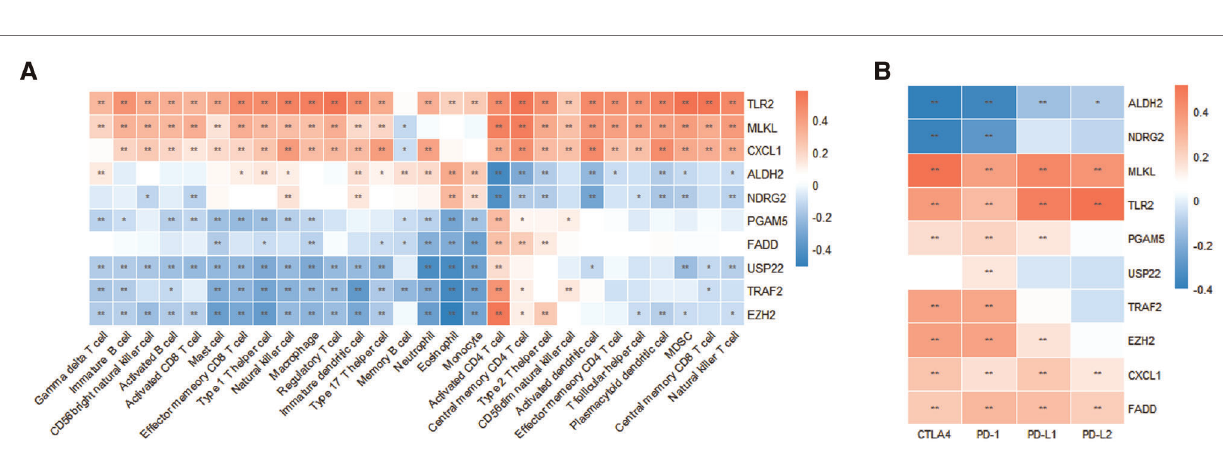
FIGURE 3 | Univariate Cox analysis, correlation analysis, and function enrichment analysis of necroptosis-related genes. ( A ) Forest map showing 18 necroptosis- related genes for HCC identi fi ed by univariate Cox analysis. ( B ) Correlation visualization matrix displaying the pairwise correlation between the 10 necroptosis-related genes. ( C and D ) Function enrichment analysis of necroptosis-related genes.